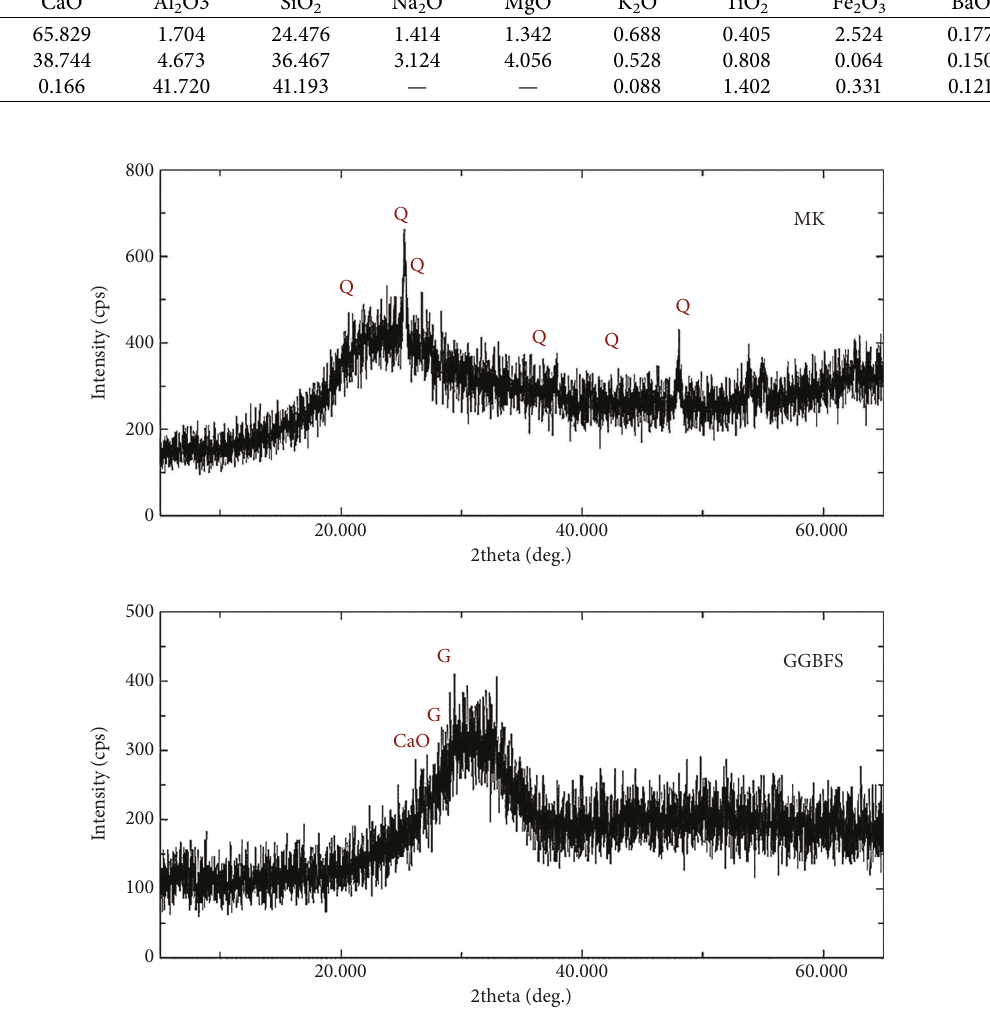
Figure 1: XRD diffractions forms for the utilized materials, GGBFS and MK. G � gypsum and Q �